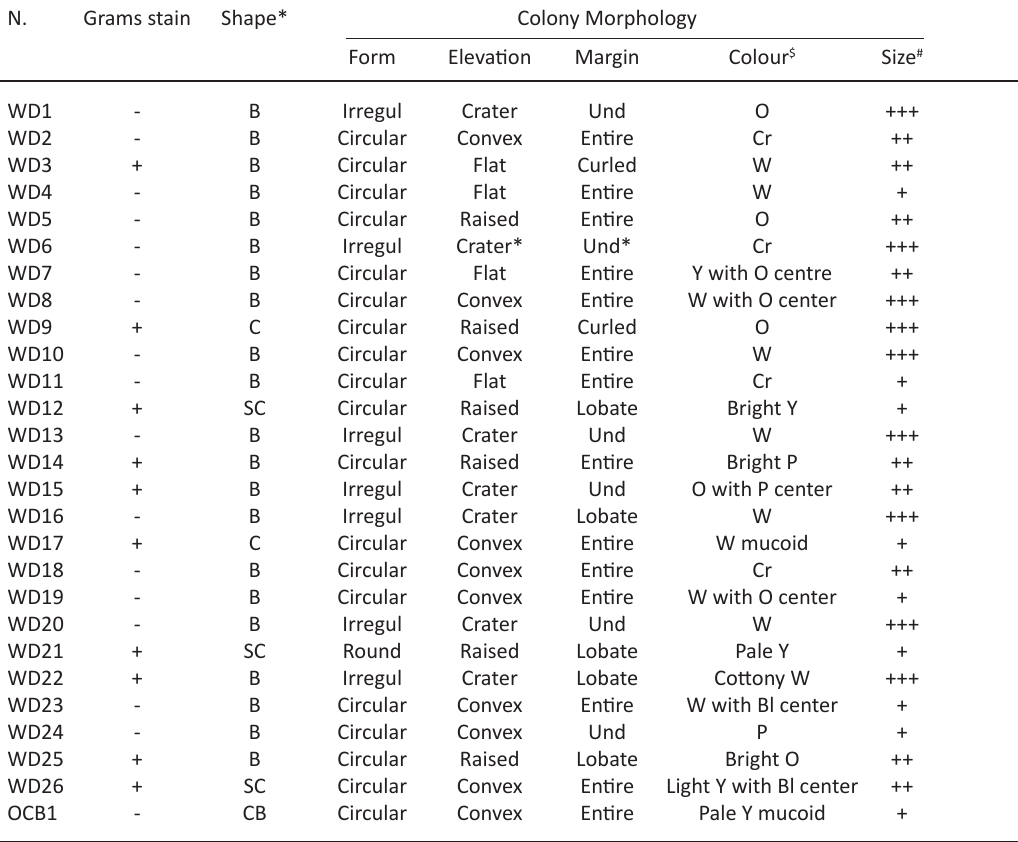
Table 4. Morphological and Colony charecteristics of isolates obtained from direct isolation